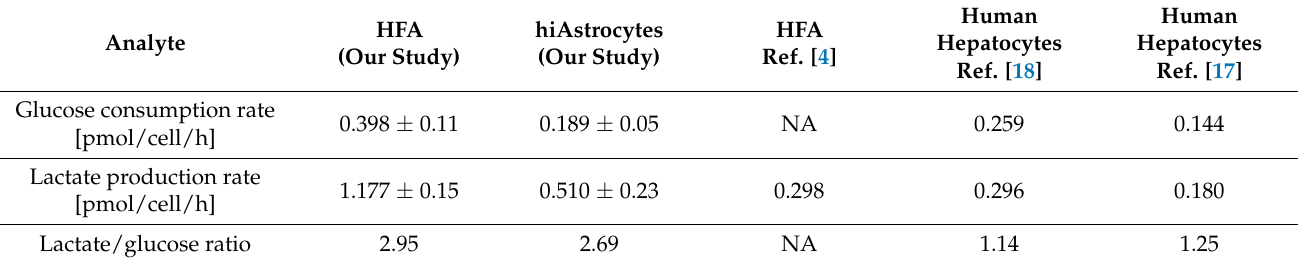
Table 2. Comparison of the median metabolic rate of the cells in our study and previous